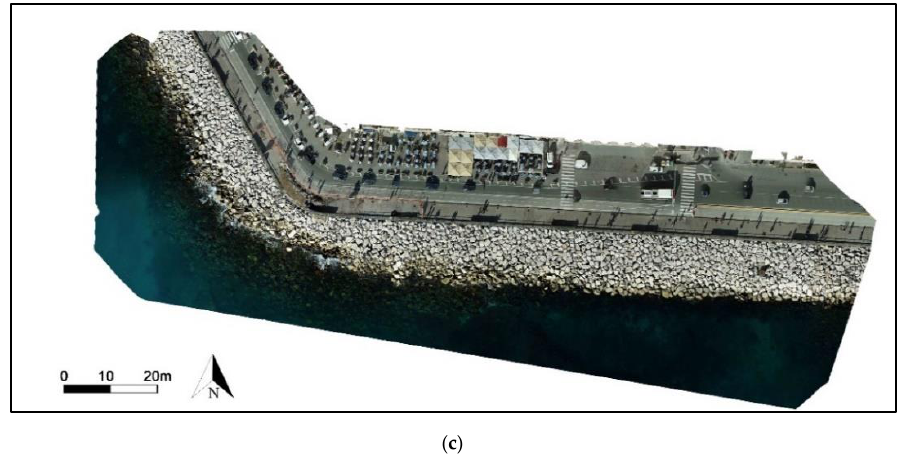
Figure 21. UAS survey and raster maps produced from low-altitude aerial images using Structure from Motion (SfM). The location of the obtained high-resolution DEM and orthophoto corresponds to the red line in Figure 18a. ( a ) Camera locations and image overlap. The black point indicates the grid plan. The different colors show the number of acquired photos; ( b ) digital elevation model (DEM); ( c ) orthophoto.